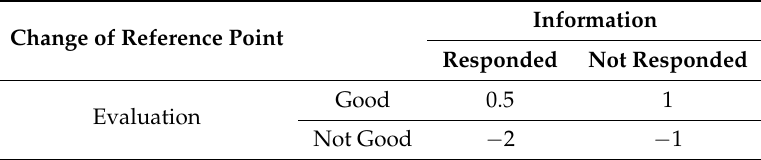
Table 6. Change of reference point.